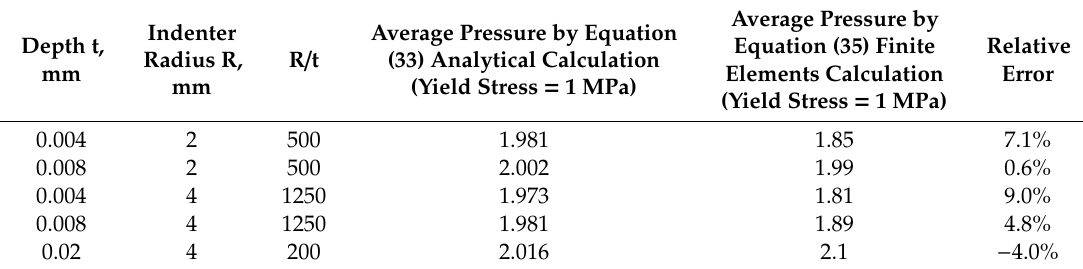
Table 1. Comparative analysis of determining the average relative pressure by numerical and analytical methods.